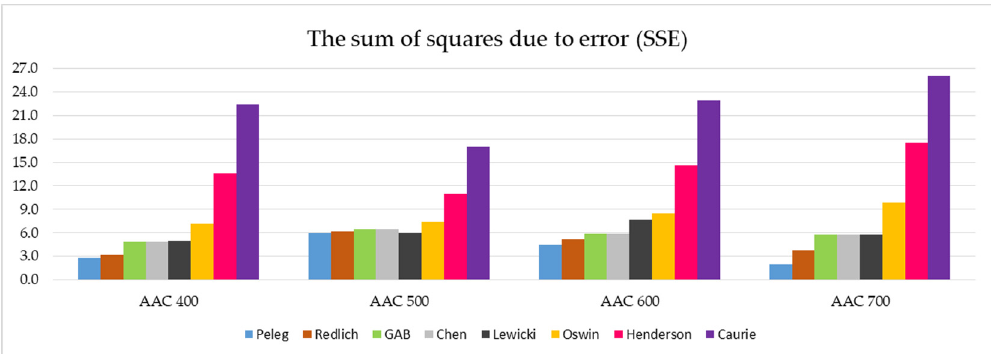
Figure 7. Graphical representation of the SSE values determined for all eight models analyzed and the four AAC density classes tested (data on individual values of SSE are presented in Table 5).